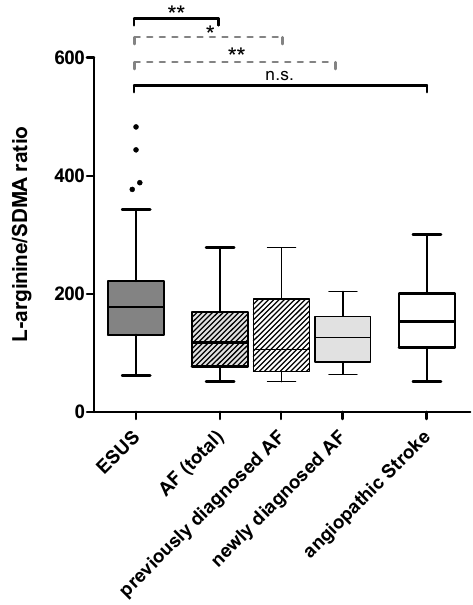
Figure 1. Group differences of L-arginine/SDMA ratio. AF (total) subsumes previously and newly diagnosed AF. * p ≤ 0.05 ** p ≤ 0.01; n.s.: not significant.